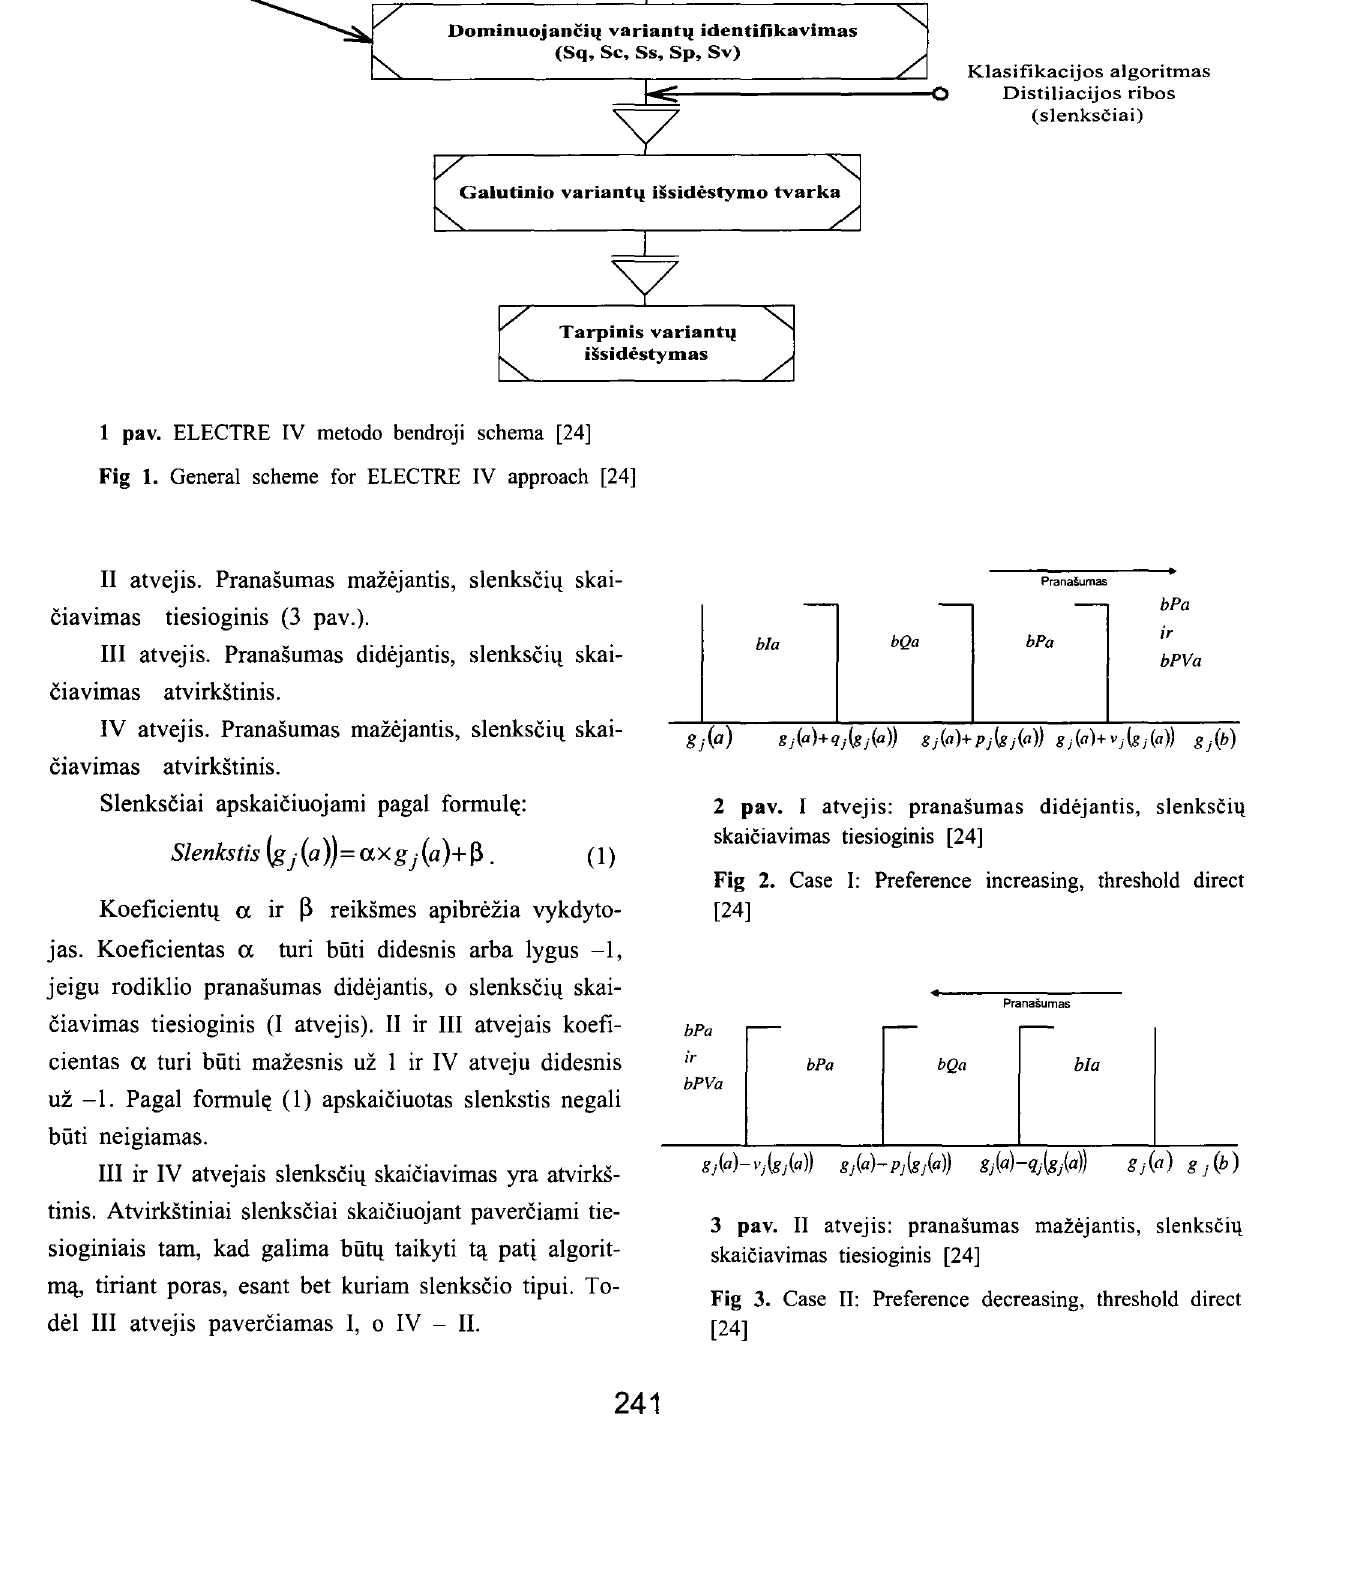
Fig 3. Case II: Preference decreasing, threshold